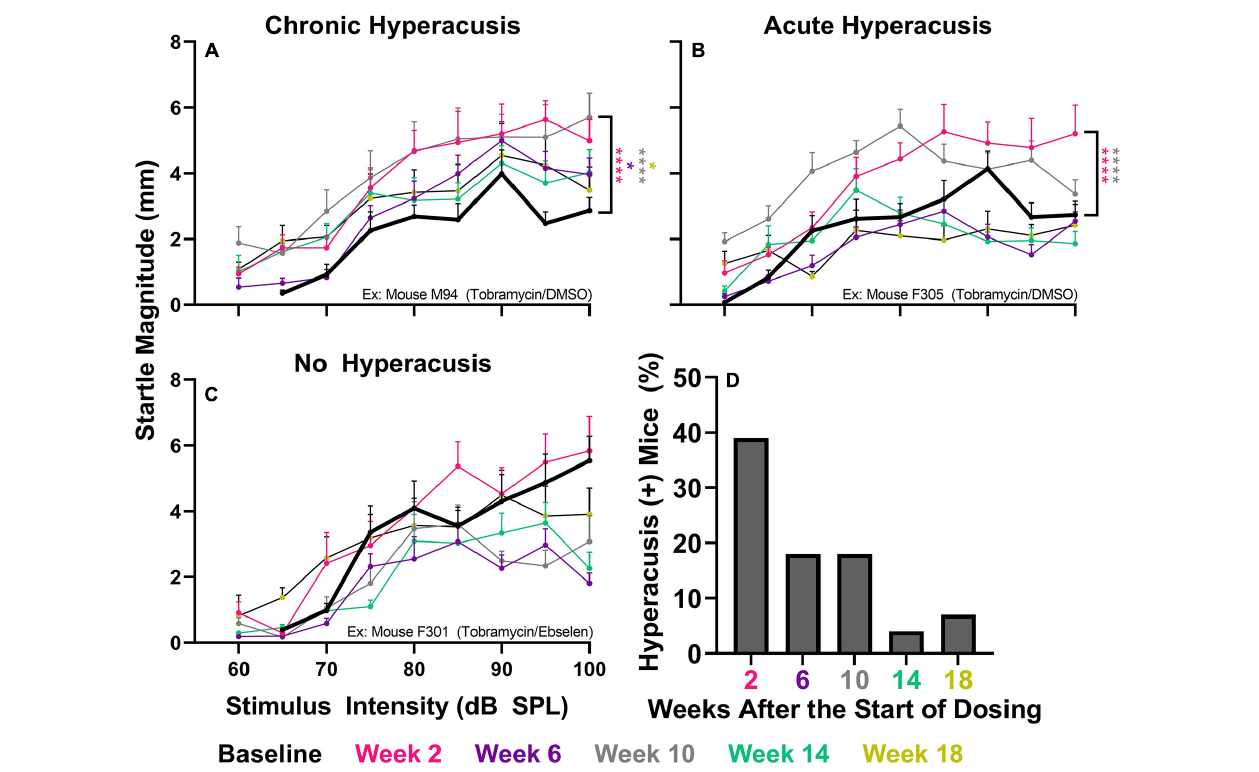
FIGURE 4 | Evaluation of behavioral evidence of hyperacusis for individual animals. IO Startle stimulus/response functions recorded from 3 representative tobramycin-treated mice. (A): Example of a tobramycin-treated mouse with chronic hyperacusis, (B): Acute hyperacusis, and (C): no hyperacusis. Startle response magnitude CMD (mm) as a function of stimulus intensity (60 to 100 dB SPL) represent each specific epoch (color coded) compared to baseline (bolded black line). Data is represented by means and standard errors. Post hoc significant differences between specific epochs (color coded) and baseline are indicated as follows: * p ≤ 0.05; ** p ≤ 0.01; *** p ≤ 0.001; **** p ≤ 0.0001. (D): Histogram representing the % of all tobramycin treated mice which showed statistically significant increases in startle IO functions at each epoch after